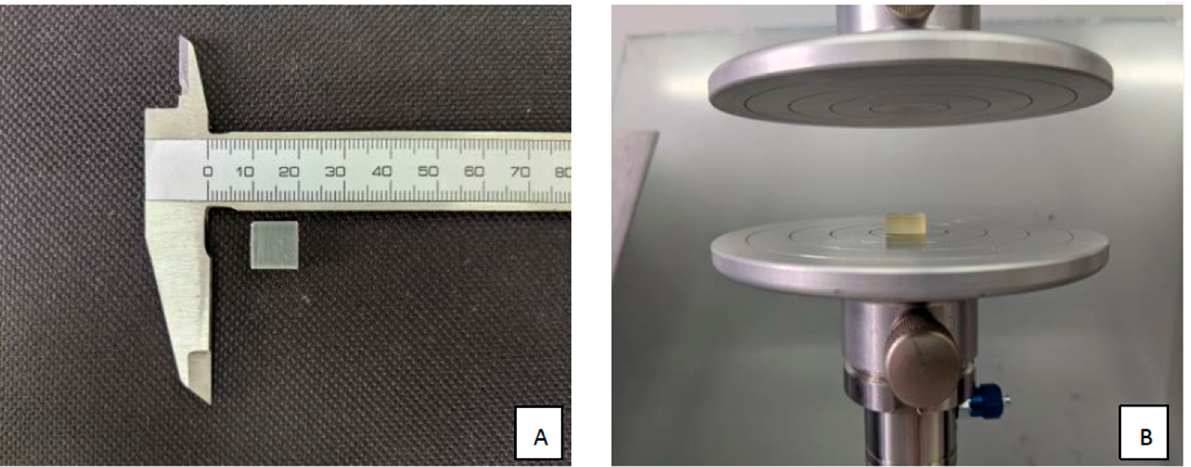
Figure 2. Axial compression test. ( A ) Sample size and form; ( B ) testing in the Universal Testing Ma- chine Z10-X700. Machine